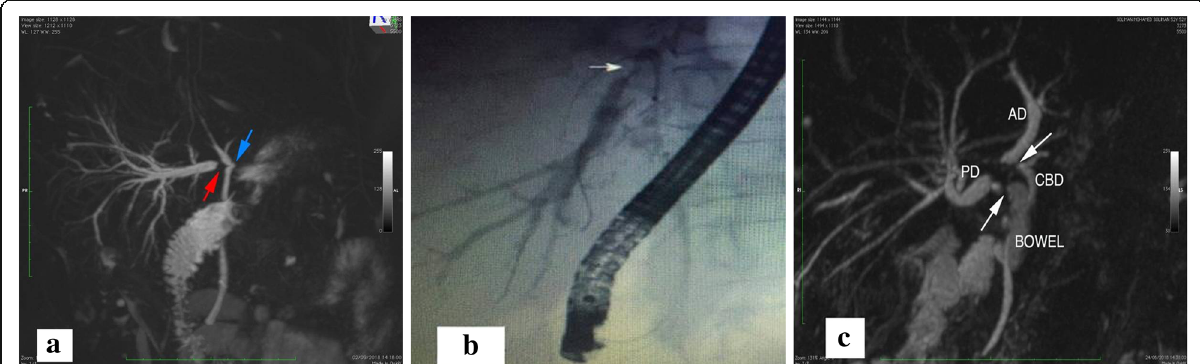
Fig. 8 A 48-year-old female 2 months after liver transplantation with duct-to-duct anastomosis as MRCP 3D MIP reconstructed coronal image showed a kink (blue arrow) at donor anterior bile duct/recipient bile duct anastomosis reflecting minimal anastomotic stricture, associated with moderate intrahepatic biliary stricture at the donor posterior bile duct (red arrow) resulting in post-transplant mixed biliary stricture ( a ). ERCP revealed a biliary stricture at the posterior sectoral bile duct (white arrow) ( b ). This patient was managed surgically by biliary-enteric